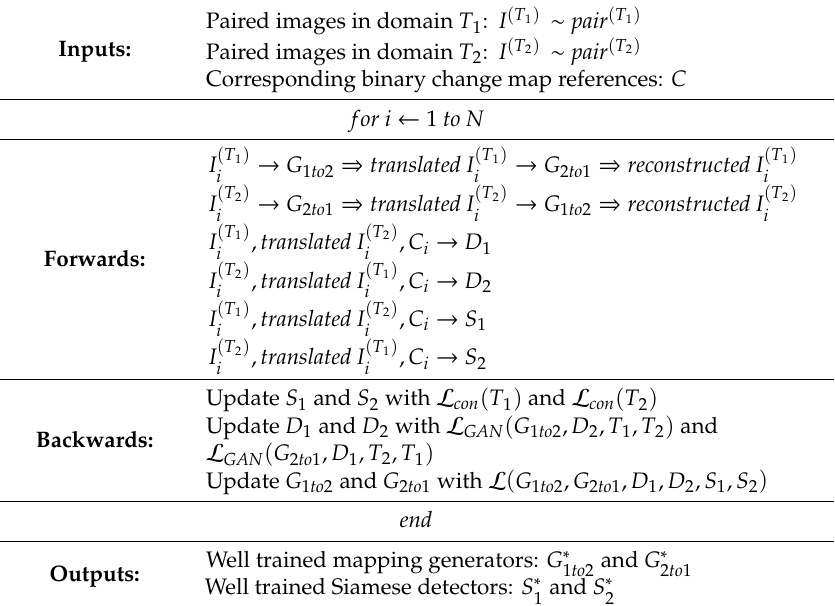
Table 2. The overview of the optimization sequence in one